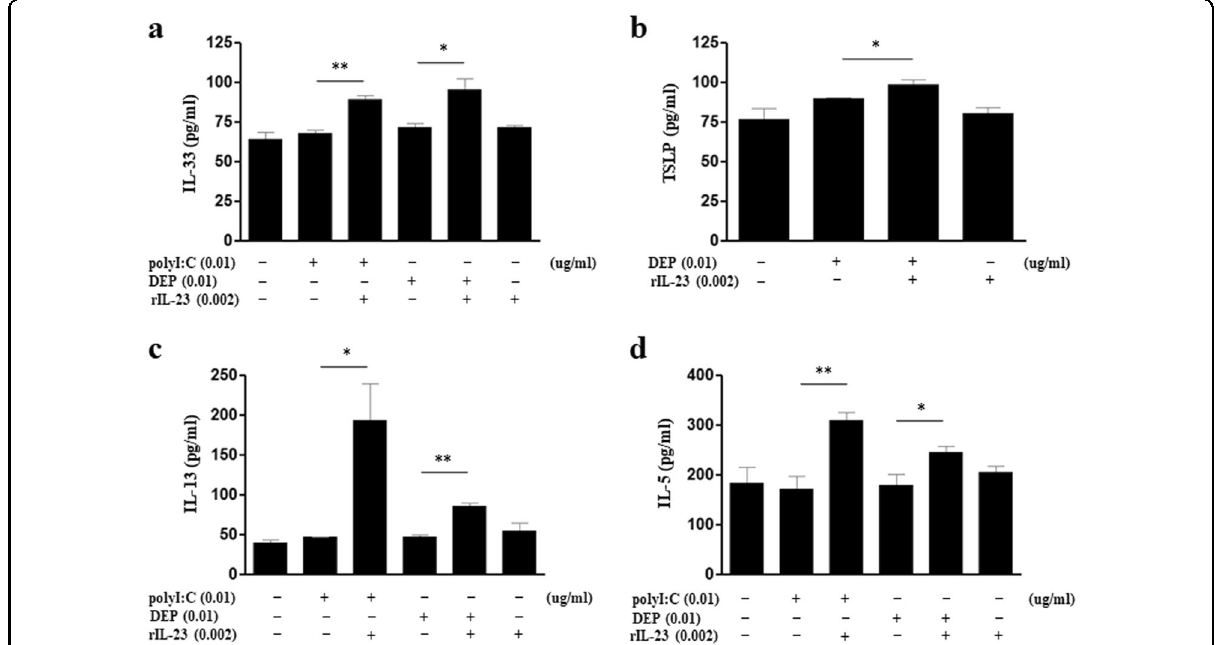
Fig. 6 Effect of exposure to polyI:C/rIL-23-treated or DEP/rIL-23-treated MLE12 cells on ILCs. a IL-33 levels in the nuclei of MLE12 cells. b TSLP levels in the cytosol of MLE12 cells. c IL-13 levels in the supernatant of ILC2s cocultured with MLE12 cells treated with polyI:C or DEPs, with or without